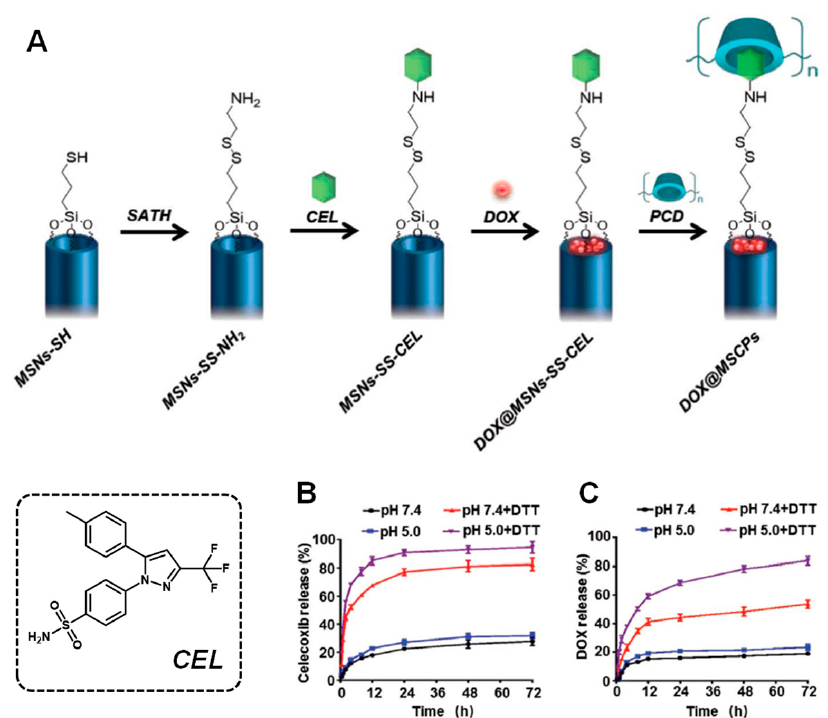
Figure 3. ( A ) Schematic representation of the redox-responsive MSNs. ( B , C ) Celecoxib (CEL) and doxorubicin release profiles, respectively, in the presence or absence of dithiothreitol (DTT), which mimics the reductive environment found inside the cells. Adapted with permission from [26]. Copyright Wiley, 2019.